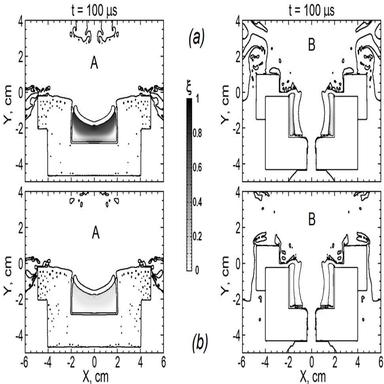
Results of the consolidation modelling (parameter ξ) for the calcite sand tests, ρ0 = 1.33 g/cm3 : as-received (a); and moisturised (b).